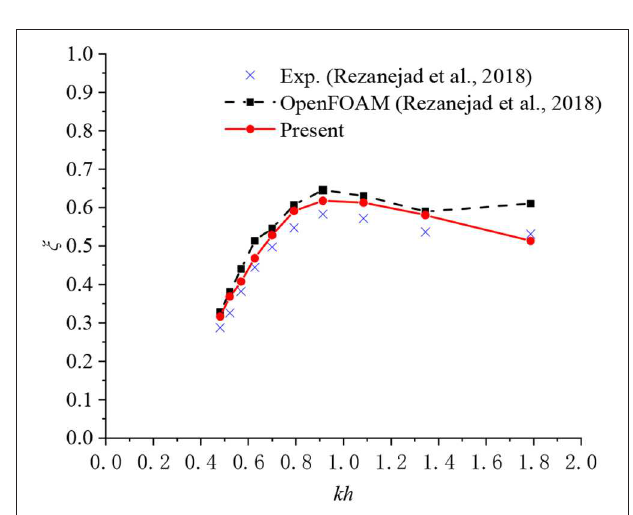
FIGURE 6 | Hydrodynamic efficiency vs. dimensionless wave